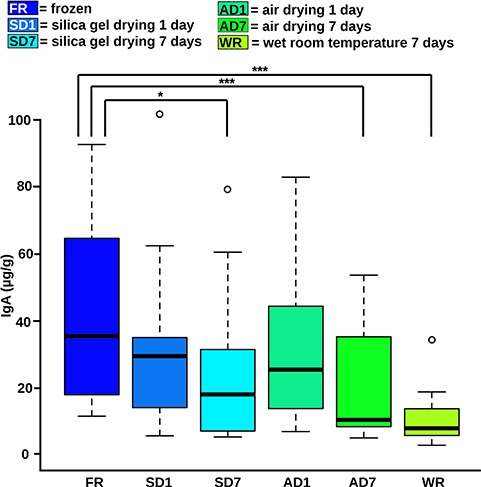
IgA concentrations. The boxes comprise 50% and each whisker 25% of the data of the particular preservation method. The line in the box represents the median and the circles above the box represent outliers. For full statistical data, see Supplementary File S4. *P < 0.5, ***P < 0.001.